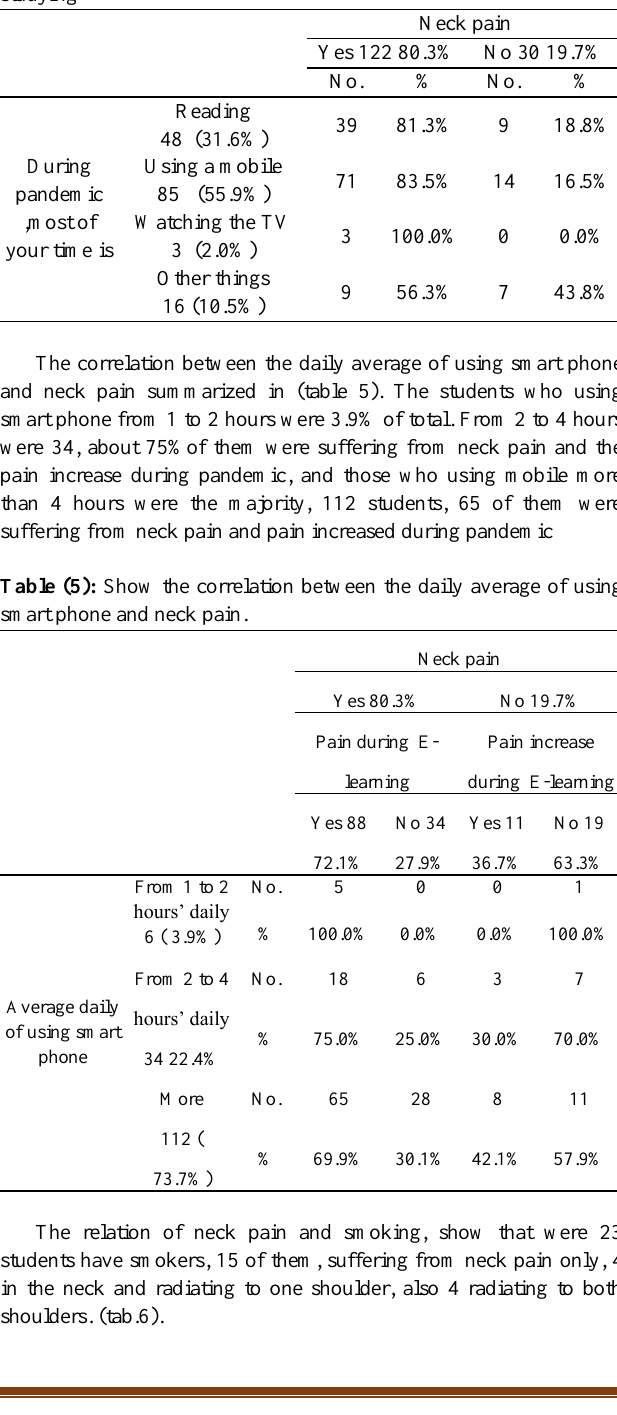
Table (4): Show the correlation between position of students during